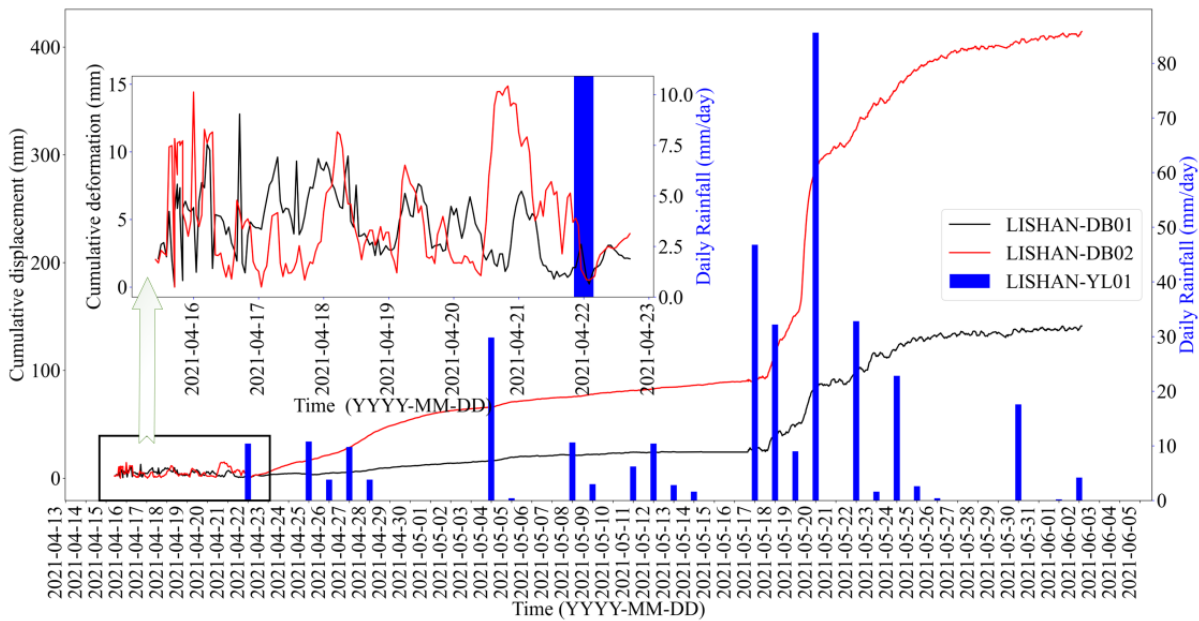
Figure 4. Monitoring data of the Lishanyuan landslide.